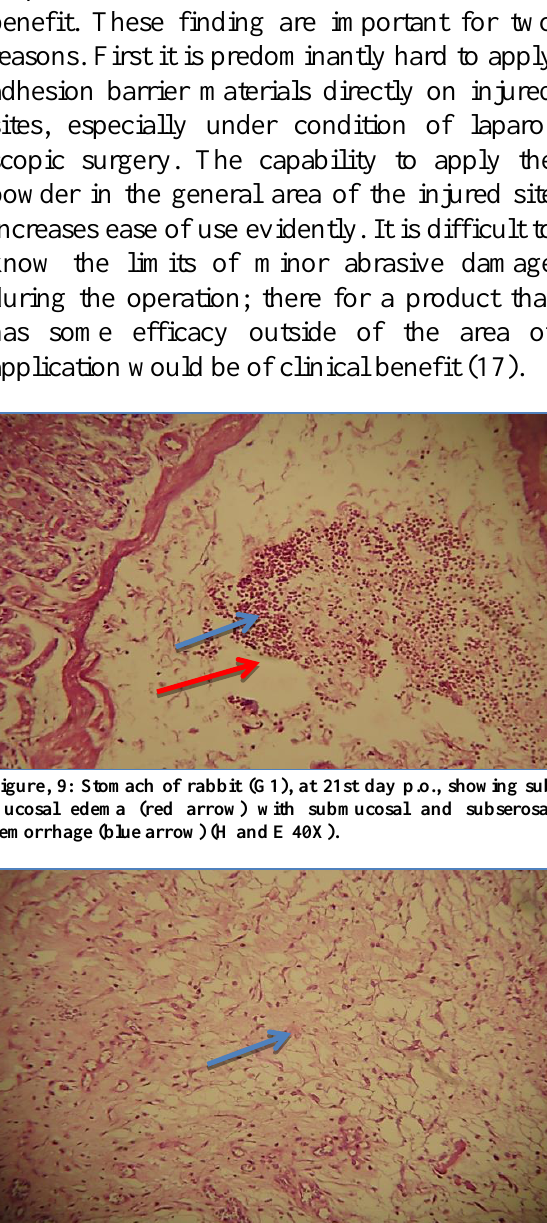
Figure, 10: Stomach of rabbit (G1), 21st p.o, showing proliferation of granulation tissue undergo myxomatous degeneration (blue arrow) (H and E 40X).